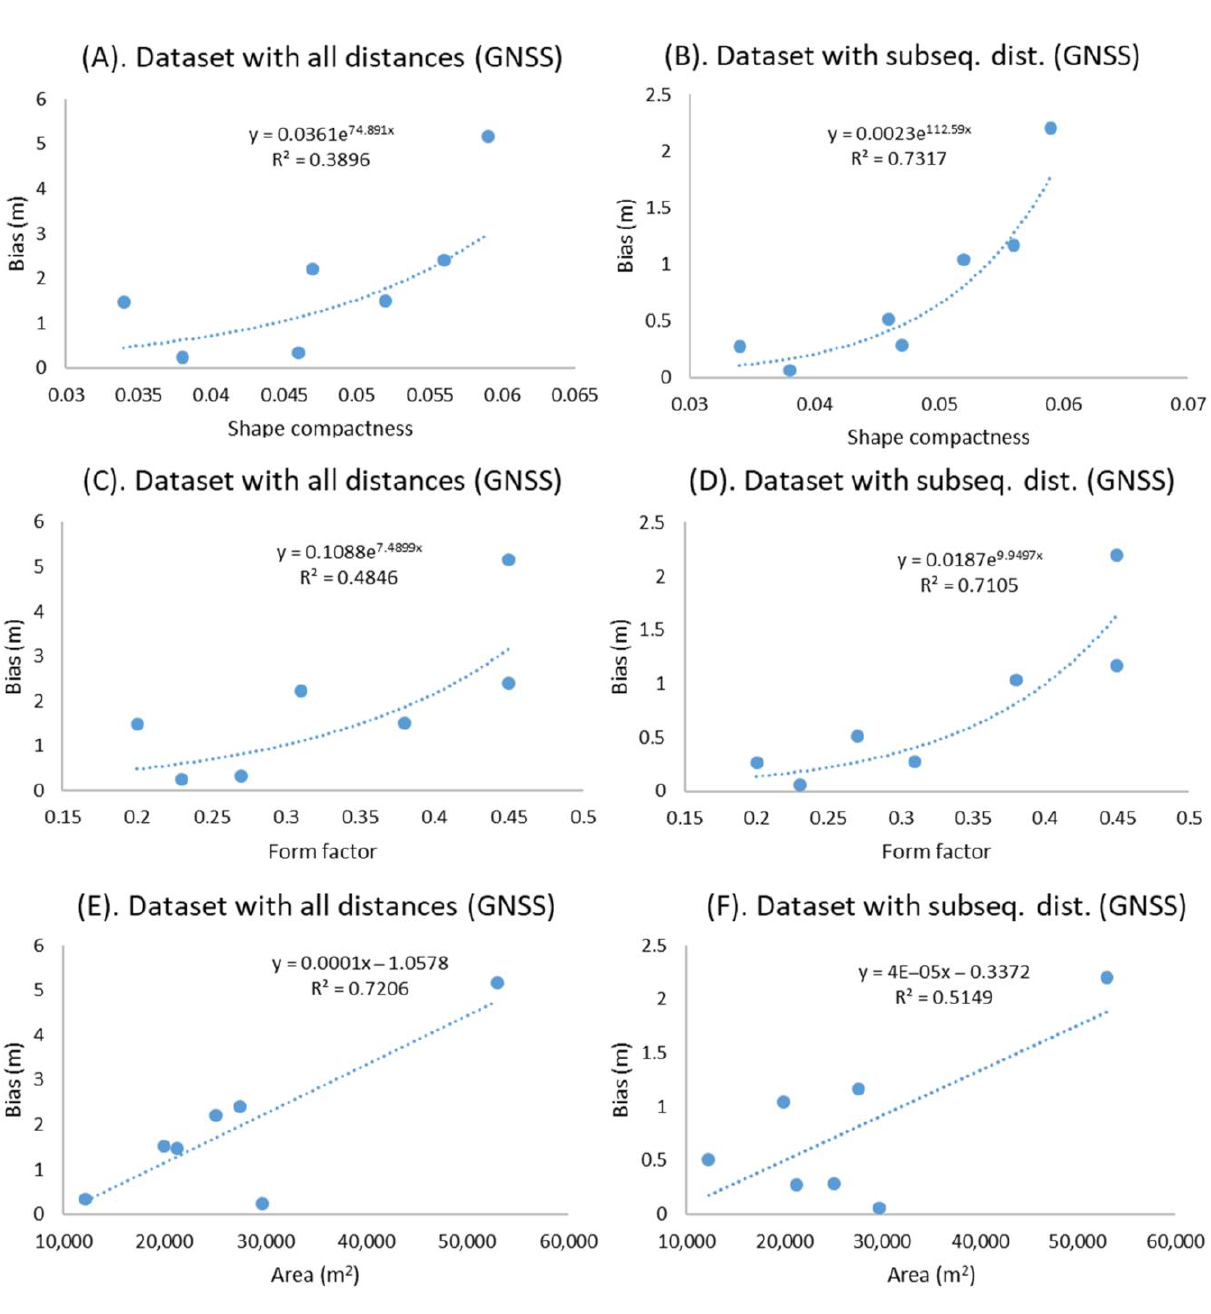
Figure A2. Scatter plots showing the influence of shape compactness ( A , B ), form factor ( C , D ), and area of the convex hull encompassing the points recorded by GNSS ( E , F ) on the mean difference between the two instruments (bias). Plots were drawn for both cases—bias determined in the case of distances between all points in a dataset ( A , C , E ) and distances between subsequent points in a dataset ( B , D , F ). (blue dots represent the observations; the regression line is represented by the dotted blue line).